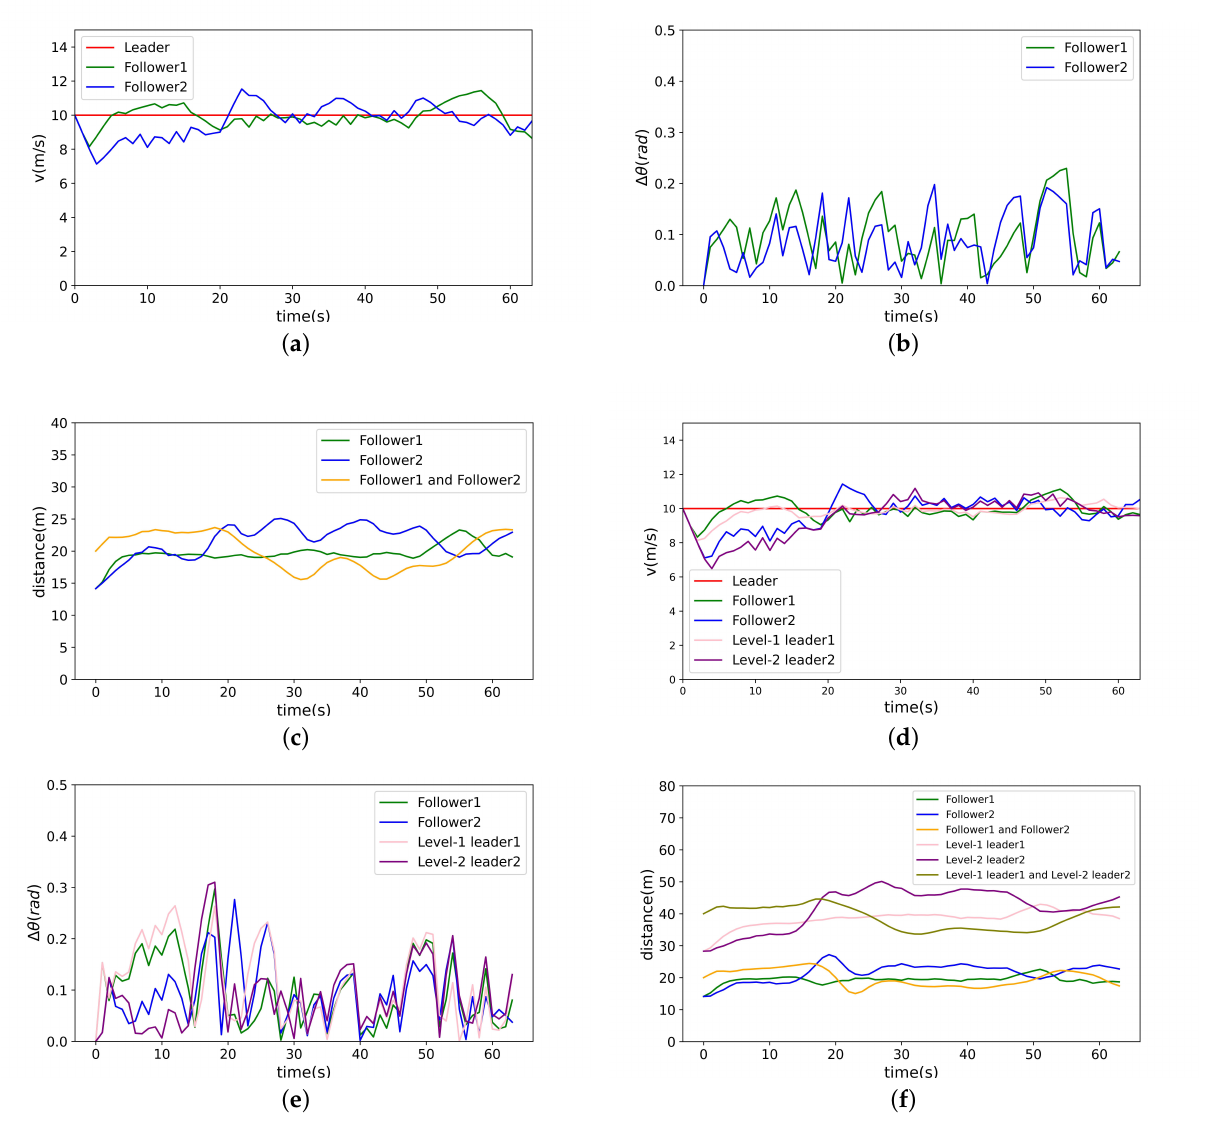
Figure 15. Performance of a basic single-layer triangular formation and a double-layer triangular formation, respectively, in the test. ( a , d ) The relationship between a follower’s speed and time. ( b , e ) The relationship between the follower and the leader’s heading angle difference with time. ( c , f ) The distance between followers and leader with time.